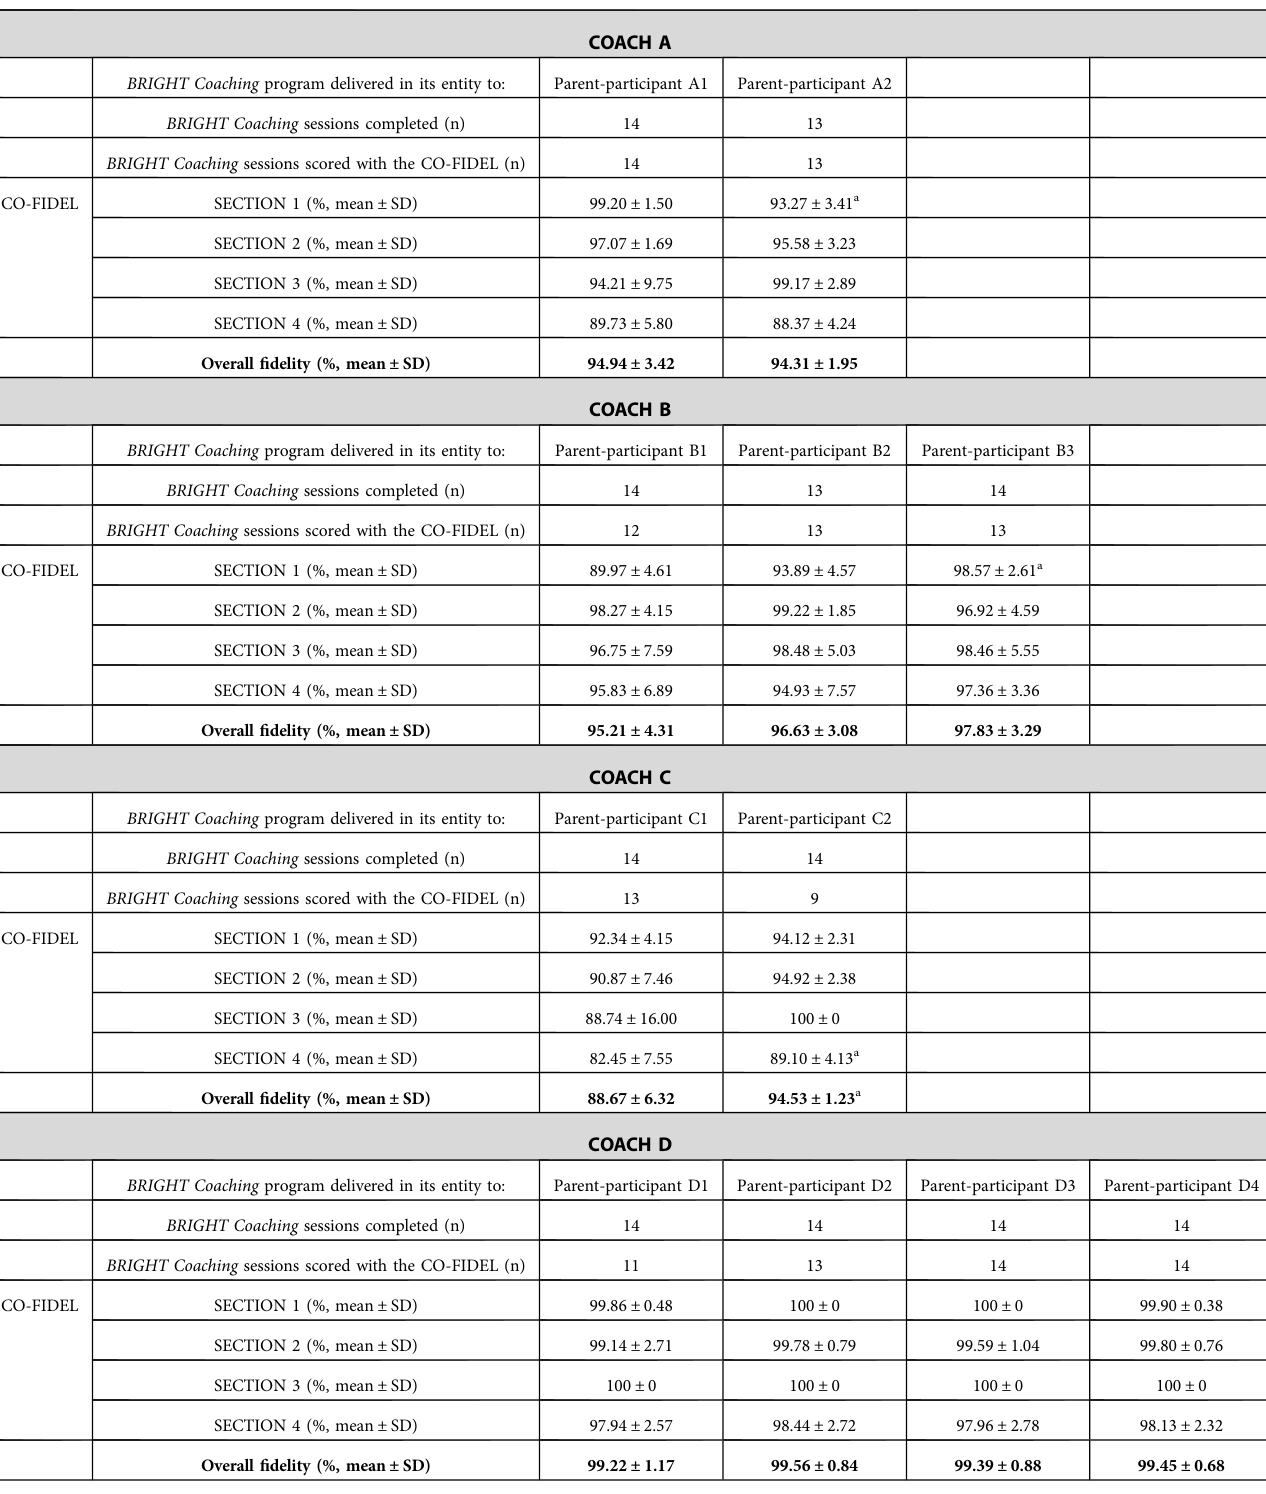
TABLE 1 CO-FIDEL results per coach and their respective